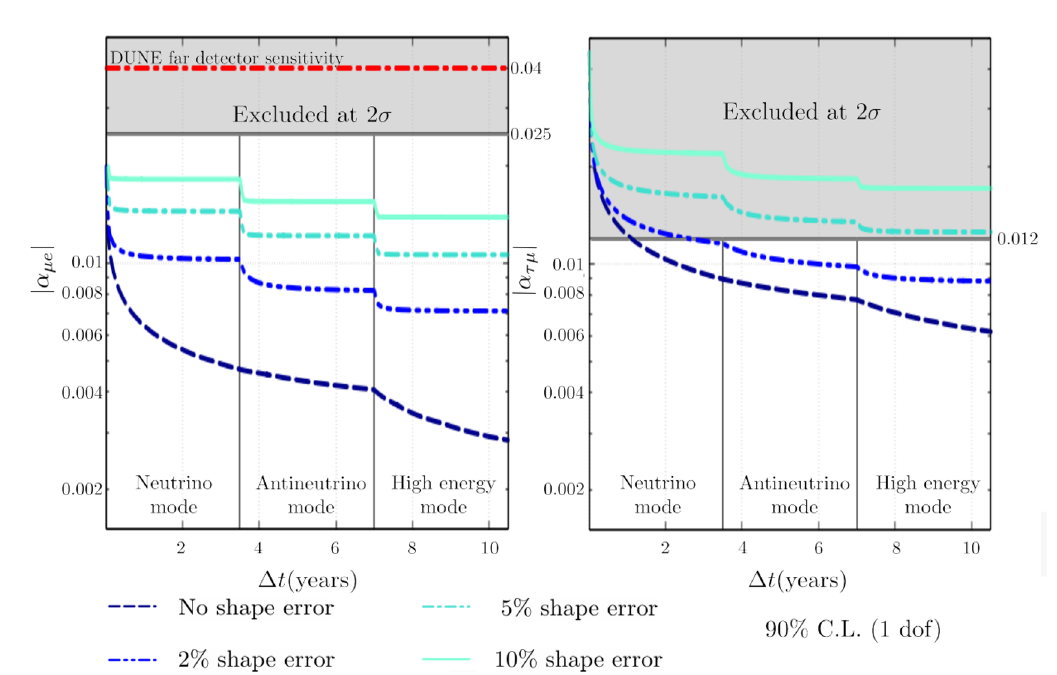
Figure 3 . Sensitivity to the off-diagonal NU parameters α µe (left panel) and α τµ (right panel). The lines show the sensitivity at 90% CL for 1 degree of freedom (d.o.f.) as a function of the running time ∆ t (in number of years), for different choices of the systematic uncertainties as indicated by the legend. The vertical lines indicate the changes between neutrino and antineutrino running modes (in the nominal beam scenario) as well as the change to the HE beam. For reference, the shaded gray areas show the region disfavored at 90% CL by current constraints. For α µe , the dot-dashed red line indicates the expected sensitivity using the far detector data (taken from ref. [46]), while for α τµ the expected sensitivity would be worse than the range shown in the figure and is therefore not